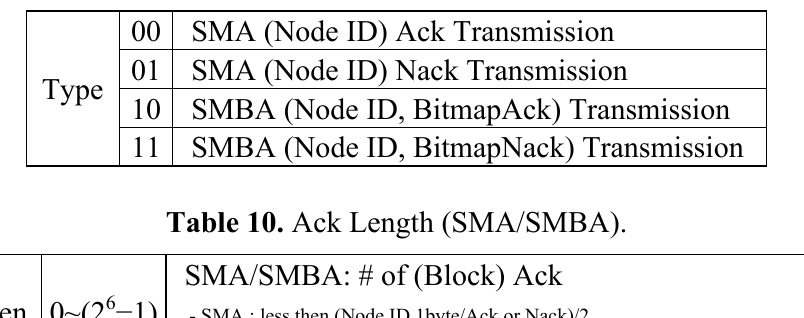
Table 9. Ack type (SMA/SMBA).